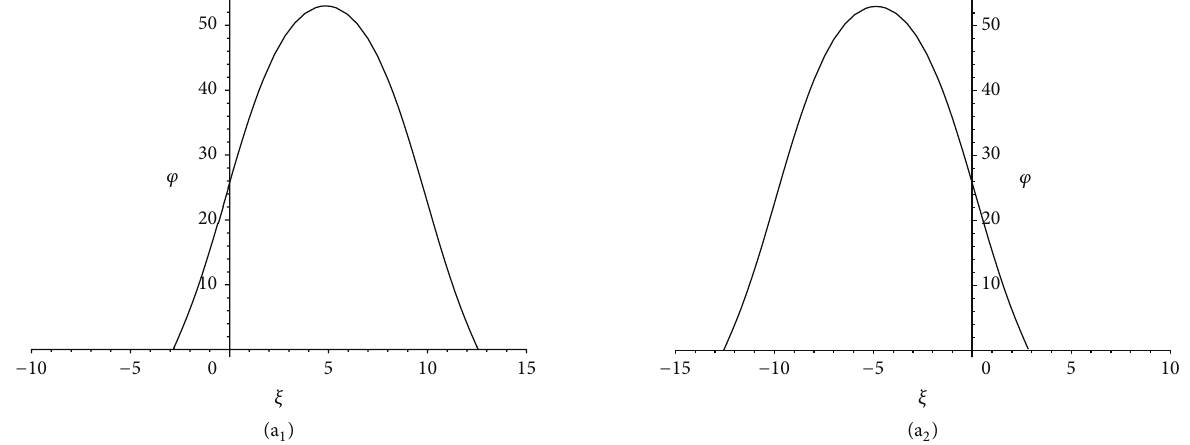
when (a 1 ) 𝛿 > 0 and (𝑎,𝑏) ∈ 𝐴 1 or 𝐴 6 or 𝑙 1 (𝑎 > 0) , (a 2 ) 𝛿 > 0 and (𝑎, 𝑏) ∈ 𝐴 2 , (a 3 ) 𝛿 < 0 and (𝑎, 𝑏) ∈ 𝐴 1 or 𝑘 𝐴 𝑙 (𝑎 < 0) , (a 𝛿 < 0 and (𝑎,𝑏) ∈ 𝑙 4 or 5 or 1 5 )